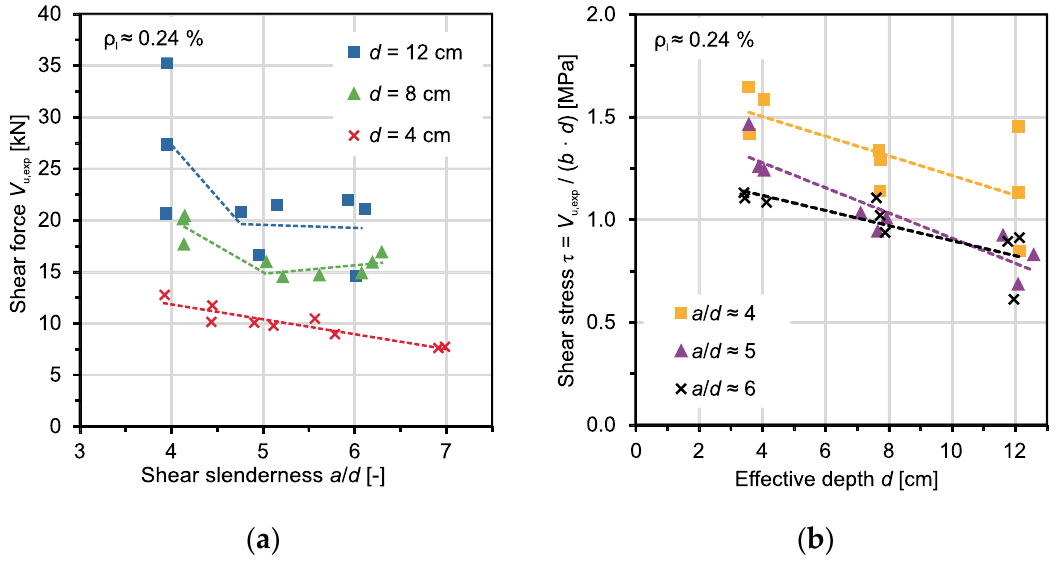
Figure 7. Results of experimental test program: ( a ) Influence of the ratio of shear span to effective depth on shear force; ( b ) Influence of effective depth on shear stress (size effect).